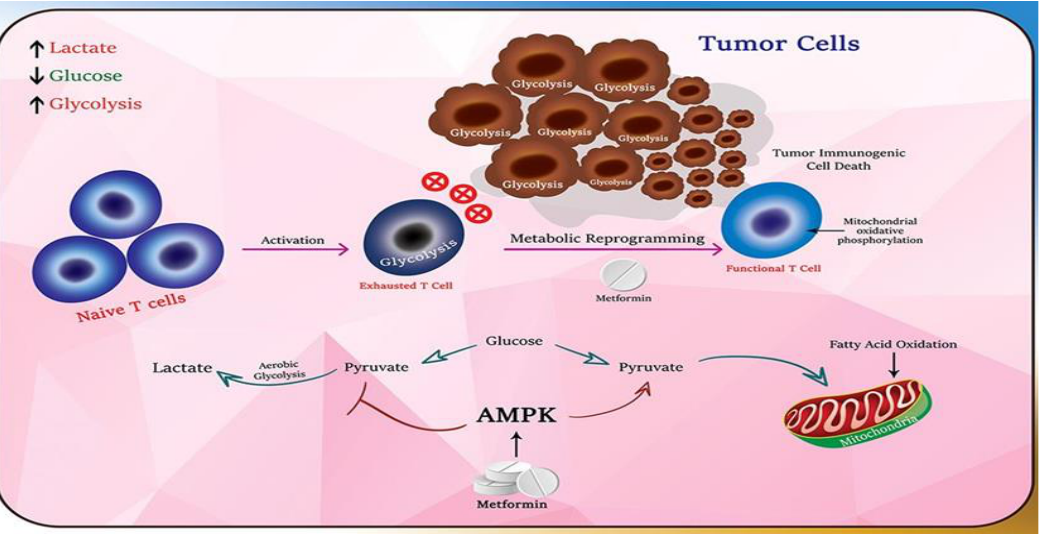
Scheme 1. Immune-mediated antitumor effects of metformin, targeting metabolic reprogramming of T cells as a new possible mechanism for anticancer effects of metformin.